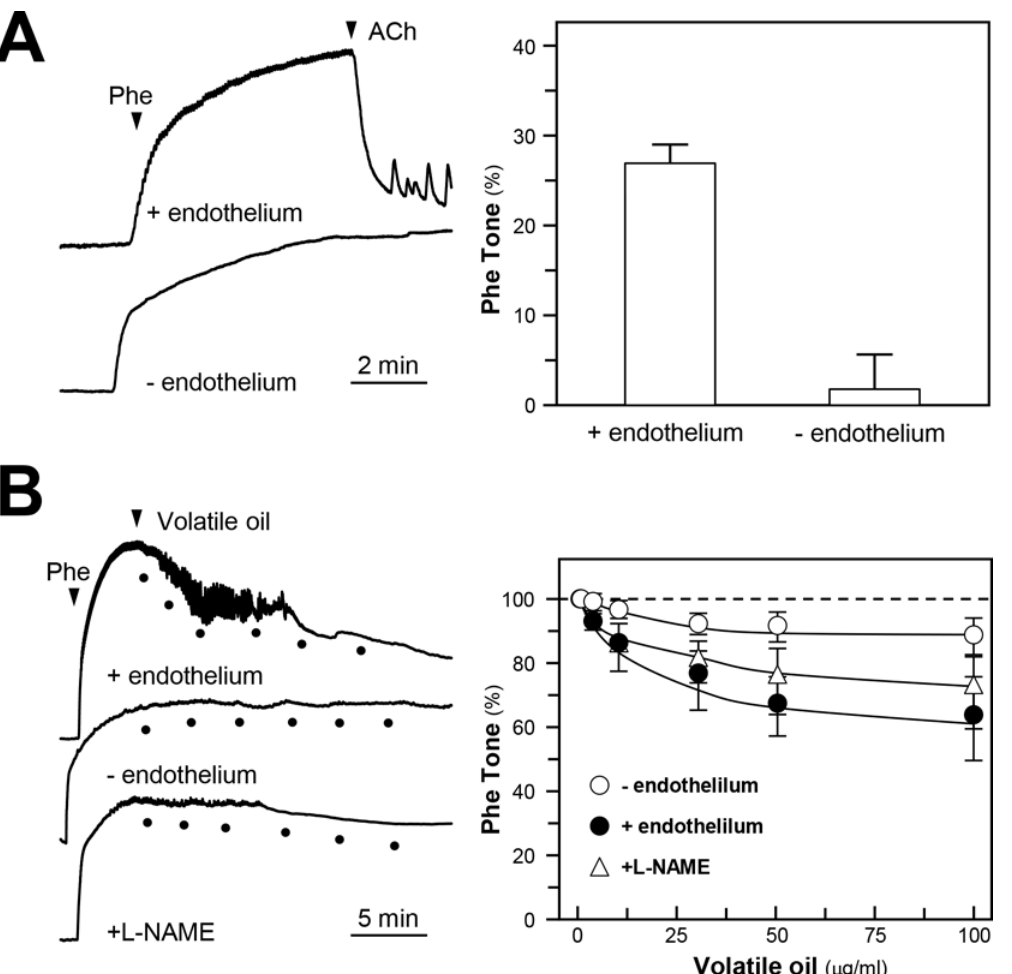
Figure 1. NRR volatile oil induces vasodilation of rat aortic ring. (A): Rat aortic ring was isolated with or without intact endothelium, the vasoconstriction was induced by the applied phenylephrine (Phe, 0.5 µ M); acetylcholine (ACh, 1 µ M) was then added (left panel). (B): The contraction of aortic ring was tested similar to (A). Different concentrations of NRR volatile oil (1, 3, 10, 30 and 100 µ g/mL) were added to induce the relaxation. Also, L-NAME (100 µ M) was applied for 30 min, and then different concentrations of NRR volatile oil were added. Values are expressed as percentage of Phe tone as comparing to the control resting tension (right panel). Mean ± SEM, n =